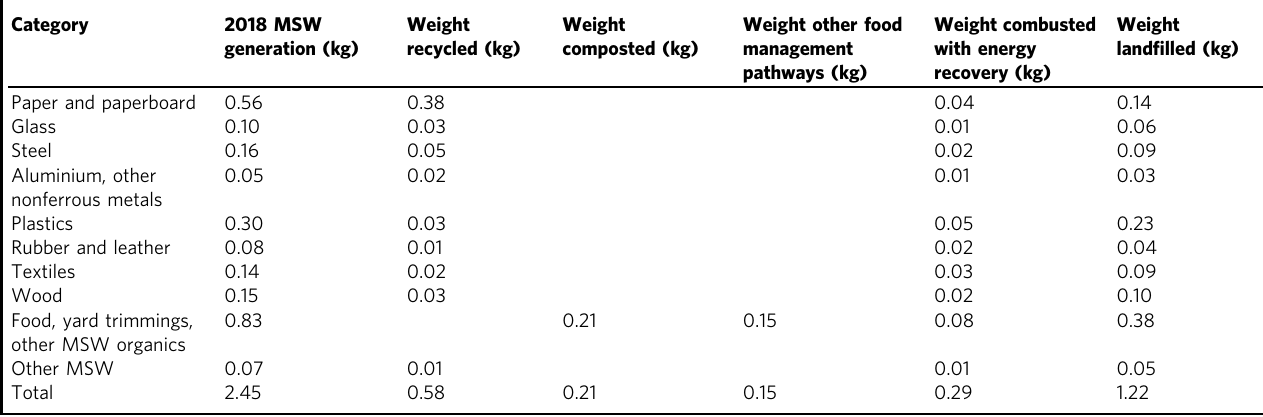
Table 3 Average amount, composition, and management pathways of municipal solid waste (MSW) in the U.S. per capita per day 48 . Blanks represent missing values.